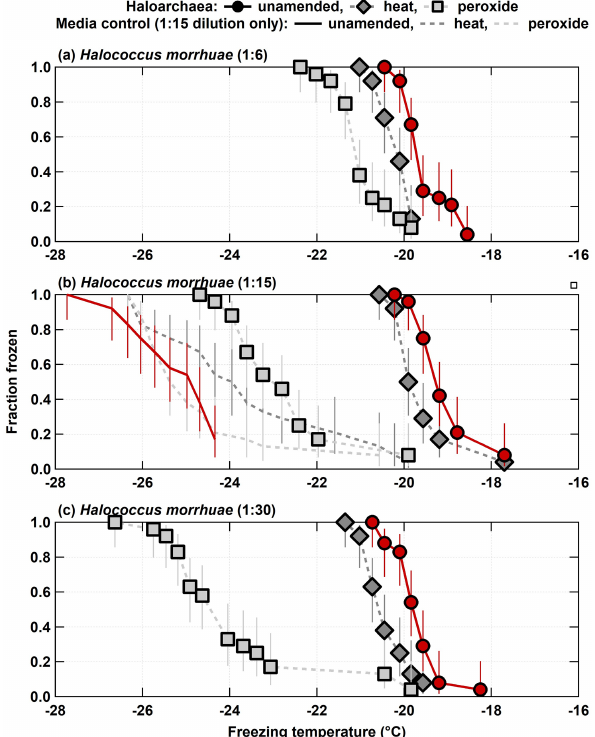
Figure 2. Unamended, heat labile (heat), and organic (peroxide) frozen fractions for each of the three H. morrhuae dilutions from the processing treatments. Note that media controls were only con- ducted for the 1 : 15 dilution. Error bars indicate 95% confidence intervals.